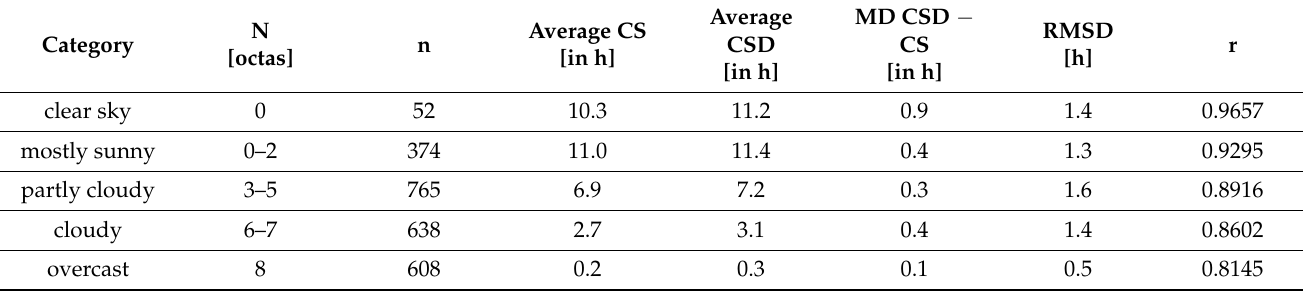
Table 5. Comparison of sunshine duration recorded with the Campbell–Stokes recorder (CS) and the CSD3 sensor in Borucino under various cloud cover, 2015–2021 (based on synchronous